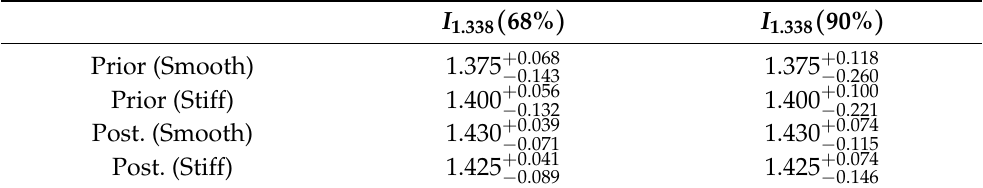
Table 5. The 68% and 90% credibility ranges for I 1.338 (in units of 10 45 gcm 2 ) associated with the smooth and maximally-stiff high-density priors as well as the two posteriors accounting for all likelihood functions included in this